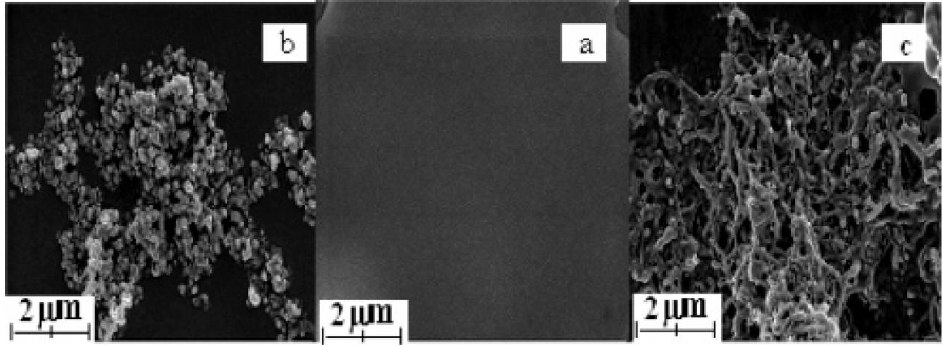
Figure 8. Scanning electron micrographs of (a) PUE, (b) Hb/PUE, and (c)